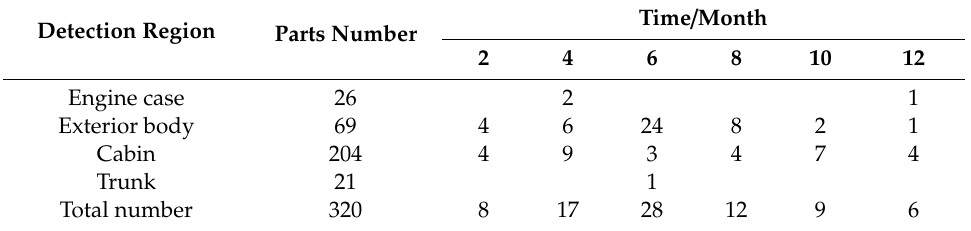
Table 3. Time and spatial distribution of newly-added appearance defects throughout the